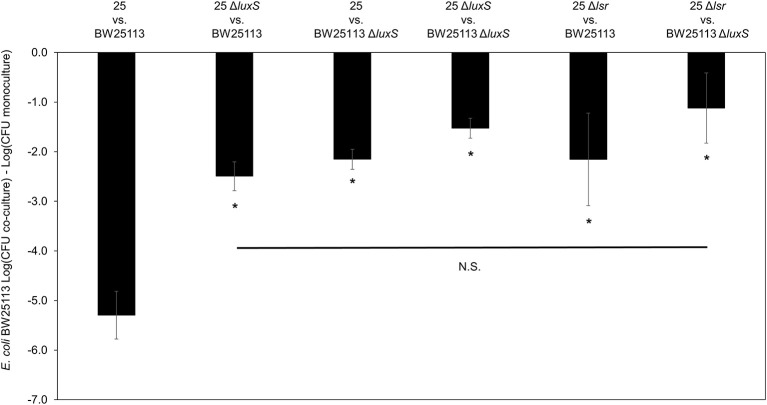
Deletion of AI-2 ABC cassette, lsrACDBFG limits the mccPDI phenotype. Competition assay between isogenic mccPDI-producing E. coli strains (25, 25 ΔluxS, and 25 Δlsr) and target E. coli strains (BW25113 or BW25113 ΔluxS) in M9 media for 8 h. Results are expressed as the difference of mean log CFU during co-culture and mono-culture (n = 3 independent replicates; error bar = SEM). *P < 0.05 compared to wild-type co-culture based on one-way ANOVA.